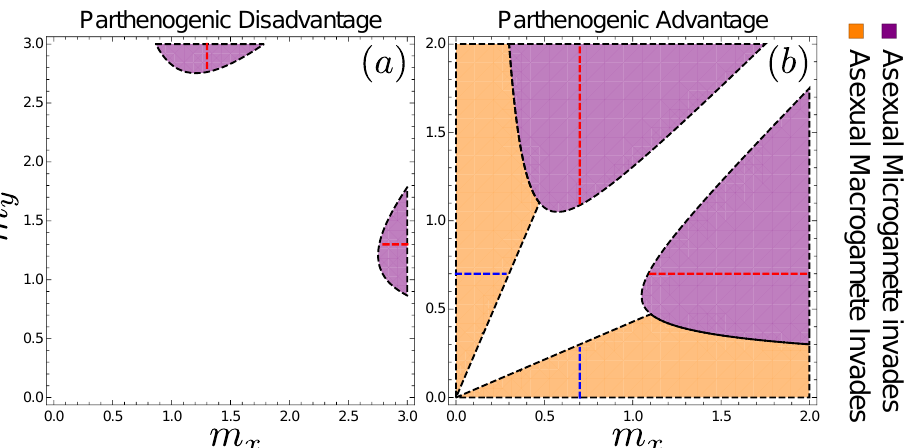
Figure 5. Invasion potential of asexuals when ( a ) β p = 1.3 > β z = 1 and ( b ) β p = 0.7 < β z = 1. Asexuality invades more easily, and can do so via mutations in either type, in ( b ) where partheno- genesis brings about a survival advantage. Microgametes can do so in ( b ), in the purple regions, which are coincident with the regions in which microgametes can drive macrogametes extinct in the absence of mutations to asexuality (see Figure 4). Note and that the plane contains regions where y is the macrogamete producer (above the diagonal) as well as x being the macrogamete producer (below the diagonal); also note the sightly larger range of the m x − m y plane depicted in ( a ), to make the microgamete invasion region visible. Isogamous sex occurs along the diagonal, where isogamous sex, should it be stable against deviating gamete sizes (as it is in ( b )), is also protected against invasion of asexual mutants as indicated by the white region in ( b ). Following the successful invasion of an asexual, the resulting evolutionary dynamics are governed by Equation (7)), taking the population to a state in which parthenogens produce gametes of size m a = β p , denoted by red-dashed lines for asexuals derived from microgametes and blue-dashed lines for asexuals derived from